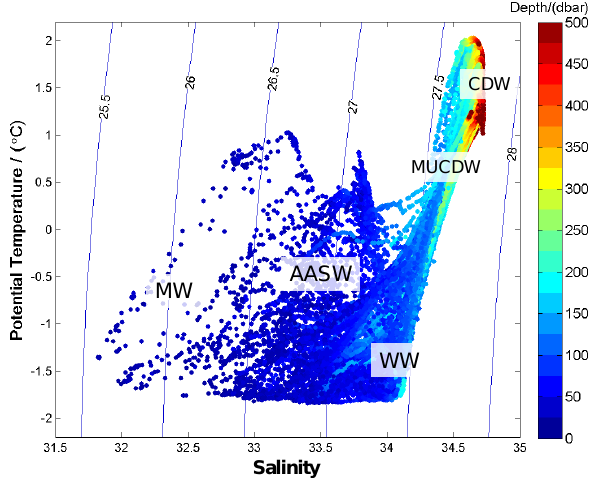
Fig. 2. T–S diagram derived from CTD profiles for identification of main water masses in the Bellingshausen Sea. Colors correspond to depth. MW, melt water; AASW, Antarctic surface water; WW, winter water; MUCDW, modified upper circumpolar deep water; and CDW, circumpolar deep water. Contours of potential density in sigma units (kgm − 3 – 1000) are shown. Fig. 3. Sea-to-air O 2 flux ( F g , left panel) and biological O 2 flux ( F bio , right panel), along the cruise track in the Bellingshausen Sea. The MIZ at the beginning (solid black contour) and at the end (dashed black contour) of the JR165 cruise are shown.